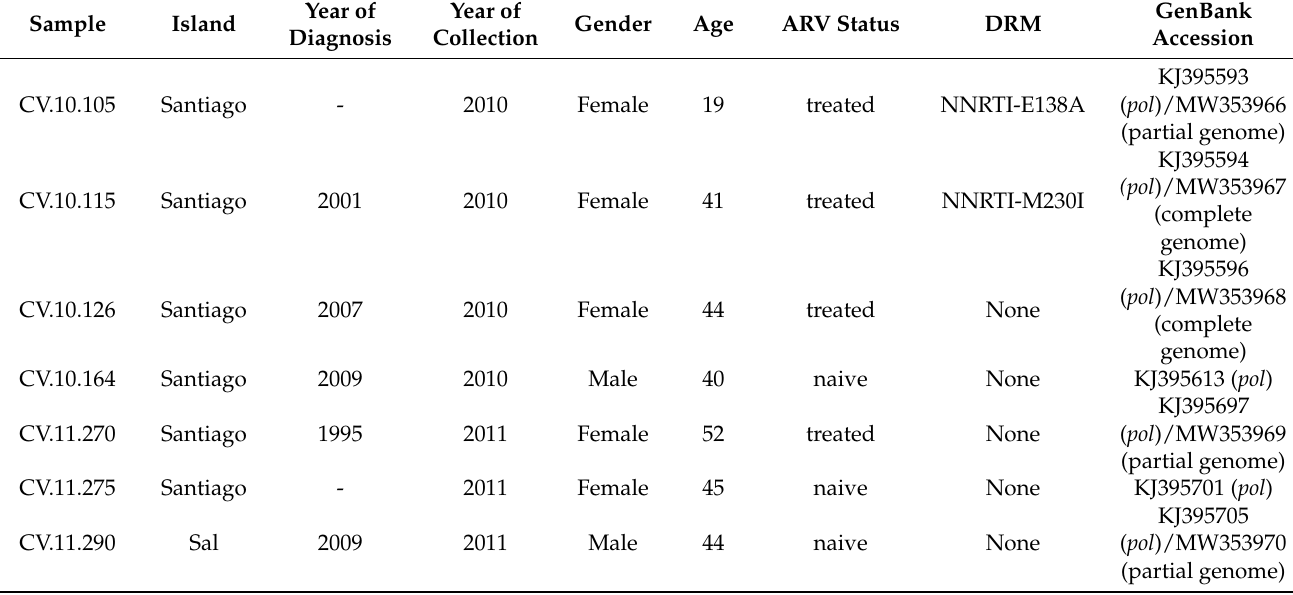
Table 1. Sociodemographic and clinical data of the studied